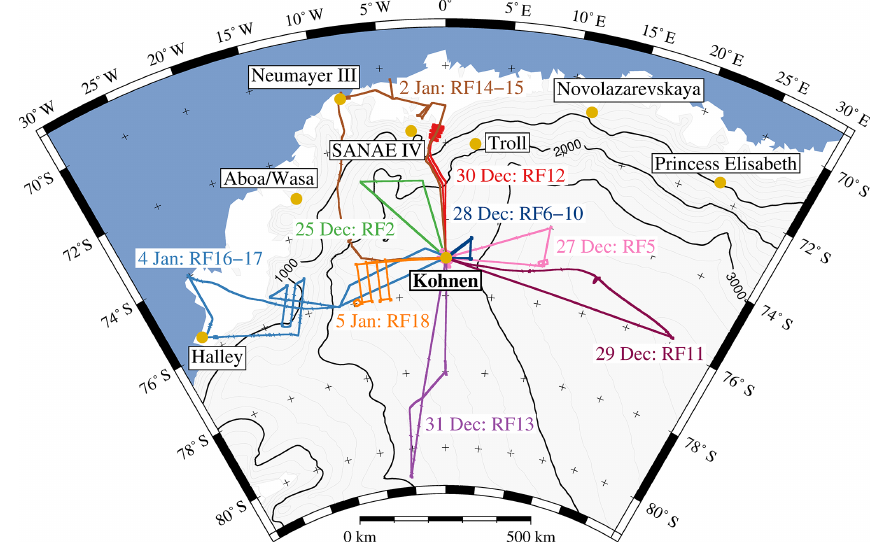
Figure 3. Map of flight patterns with the Polar 6 research aircraft during the campaign. Each color corresponds to a different